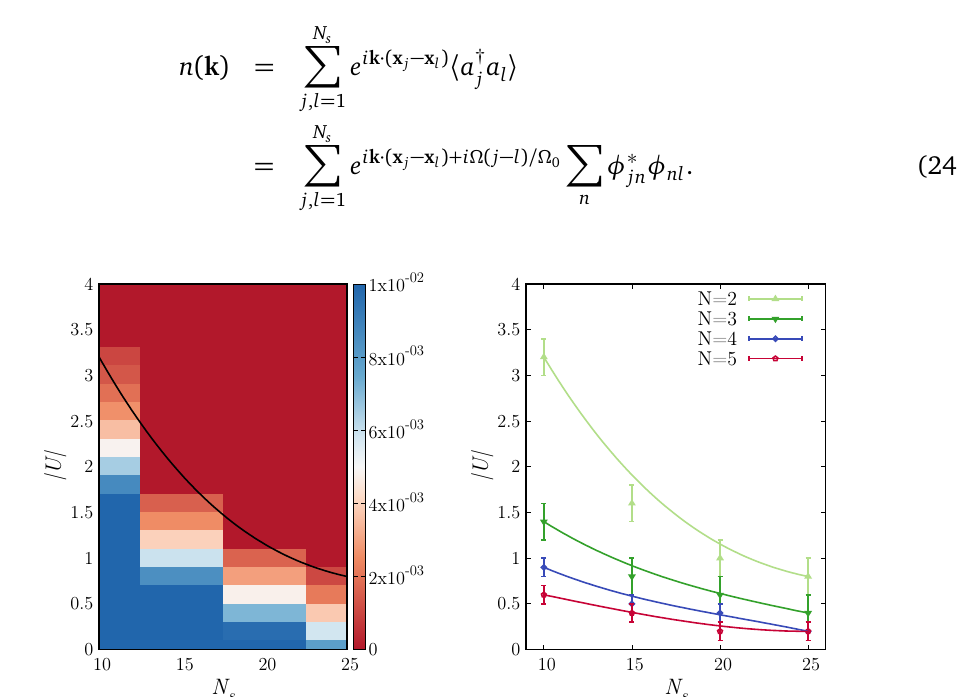
Figure 6: a Density plot of the renormalized energy difference between the N -times periodicity and the nonrotating system for N = 2. Solid lines gives the threshold ( U , N for which , N ) < 10 − 3 . In figure b we show the threshold given by condition s E ( U , N , N ) < 10 − 3 for different number of particles and system s E